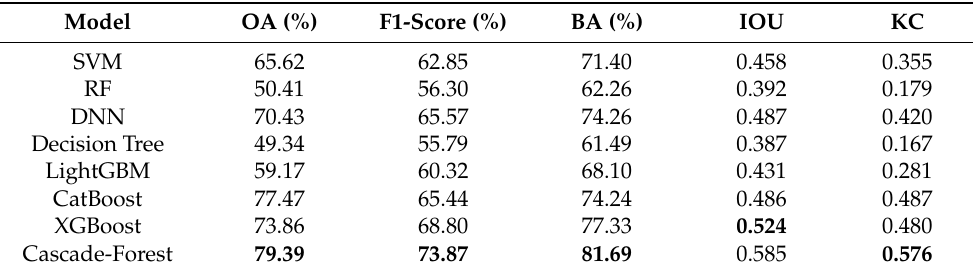
Table 6. Evaluation of the generalization of different FSM models for the first scenario. Support Vector Machine (SVM), Random Forest (RF), Deep Neural Network (DNN), Decision Tree (DT), Light Gradient Boosting Machine (LightGBM), Categorical Boosting (CatBoost), Extreme Gradient Boosting (XGBoost), and Cascade Forest Model (CFM). OA: overall accuracy; IOU: intersection over union, BA: balance accuracy; KC: kappa coefficient. The highest value is in